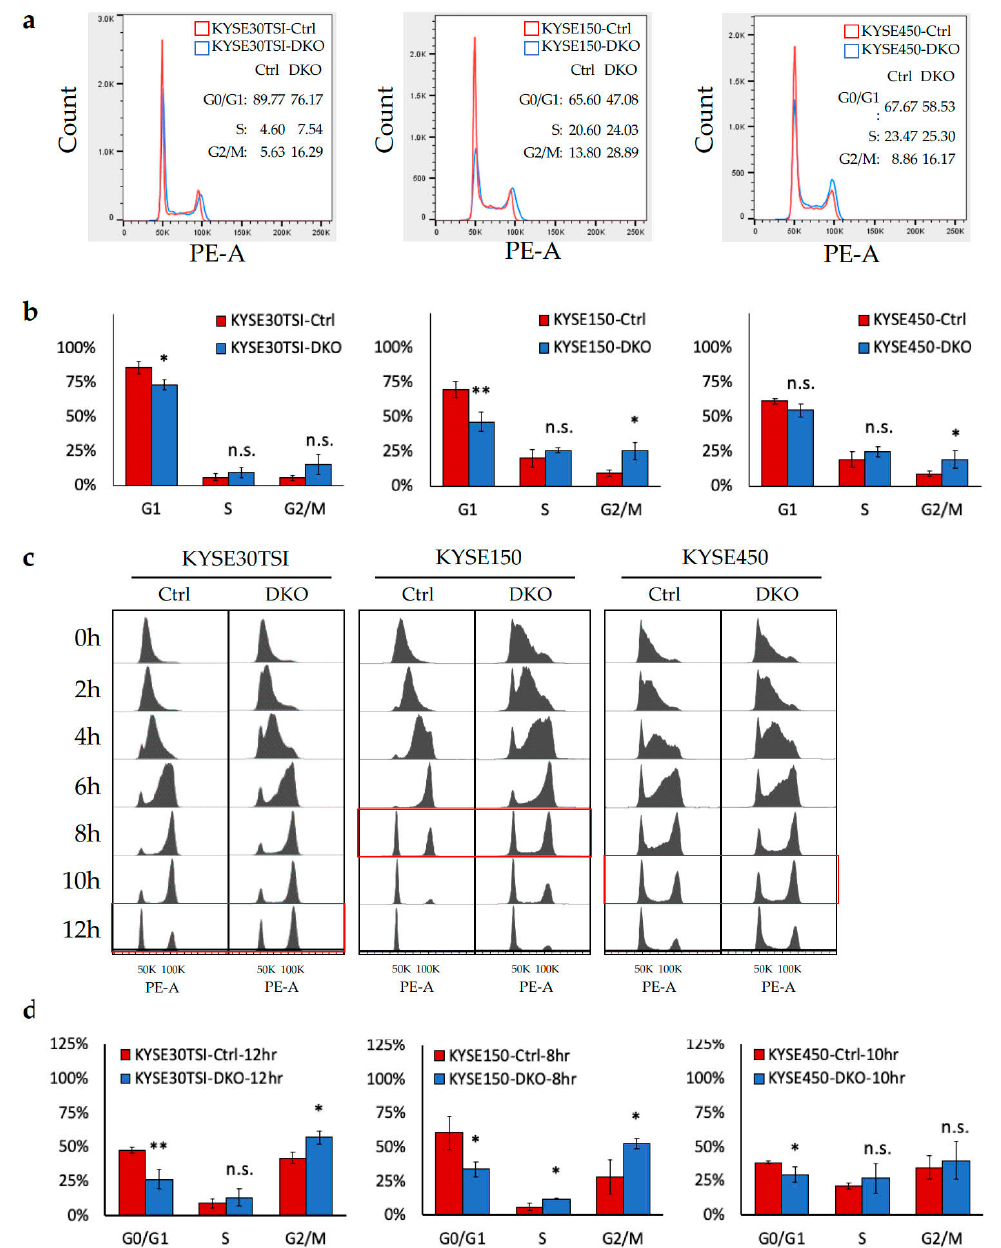
Figure 4. Analysis of cell cycle distribution and cell cycle progression in FANCD2-KO cells. ( a ) The proportion of cells in G1 / S and G2 / M phases changed in unsynchronized FANCD2-KO ESCC cell lines. Representative results are shown here. ( b ) Cell cycle profile analysis of three independent triplicate experiments expressed as the mean ± 95% confidence interval ( n = 3). ( c ) FANCD2-KO postponed cell cycle progression after the release from the G1 / S double-thymidine block. Cell cycle progression was determined by flow cytometric analysis of propidium iodide stained cells collected at the indicated time points (left). ( d ) Cell cycle profile analysis of the most significant di ff erent timepoints (highlighted with a red circle in Figure 4c) for three ESCC cell lines separately. Experiments were done in triplicates and expressed as the mean ± 95% confidence interval ( n = 3). Ctrl, control; DKO, FANCD2 knockout; * p < 0.05; ** p < 0.01; n.s. p < 0.05.